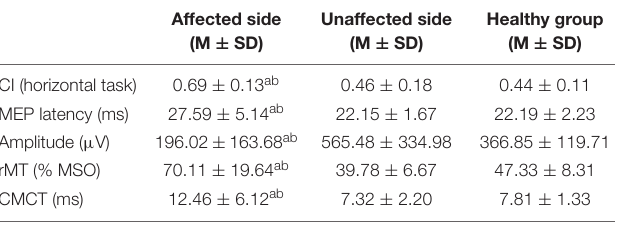
TABLE 2 | The mean (M) and standard deviation (SD) of CI and MEP parameters of stroke survivors and the healthy group.